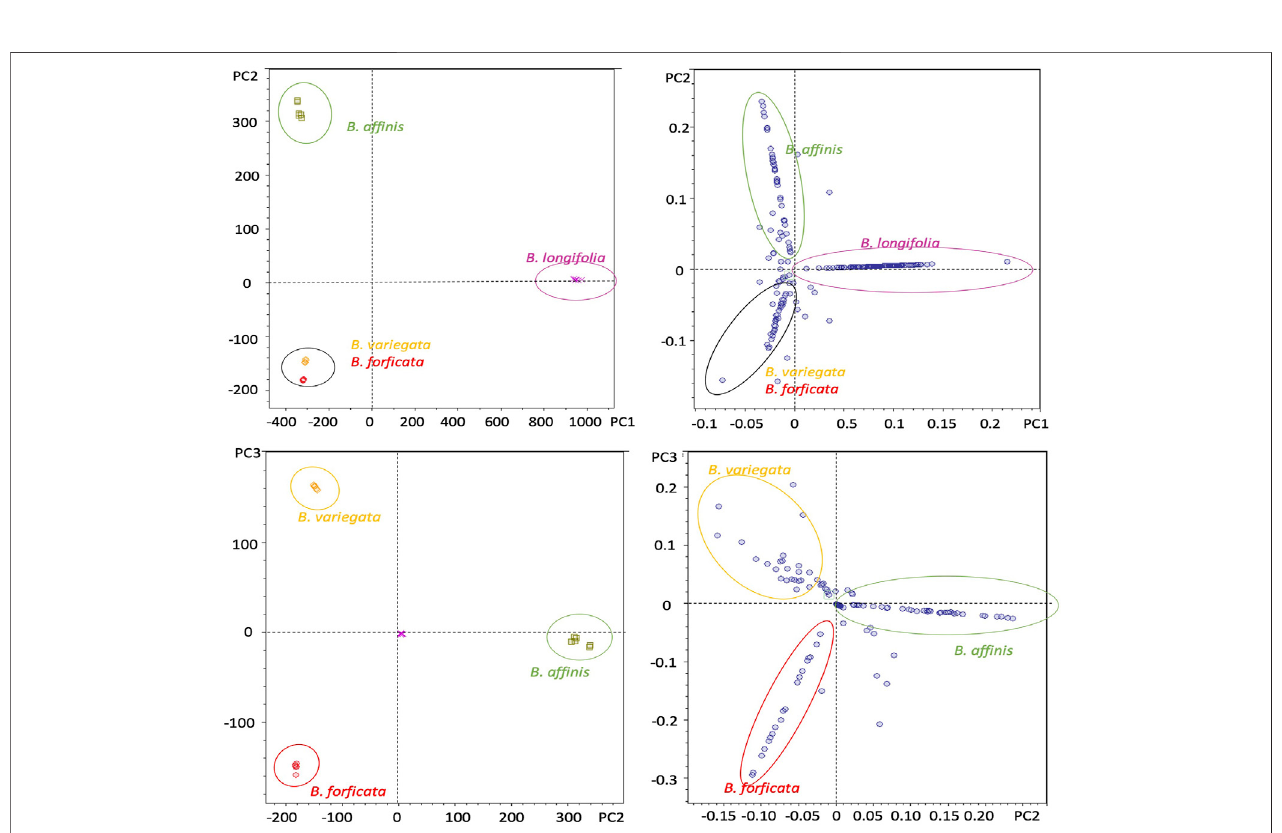
FIGURE 6 | Principal component analysis (PCA) of B. for fi cata, B. variegata, B. longifolia , and B. af fi nis . Upper: PC1 vs. PC2 (Score graphs). Bottom: PC2 vs. PC3 (loading graphs).